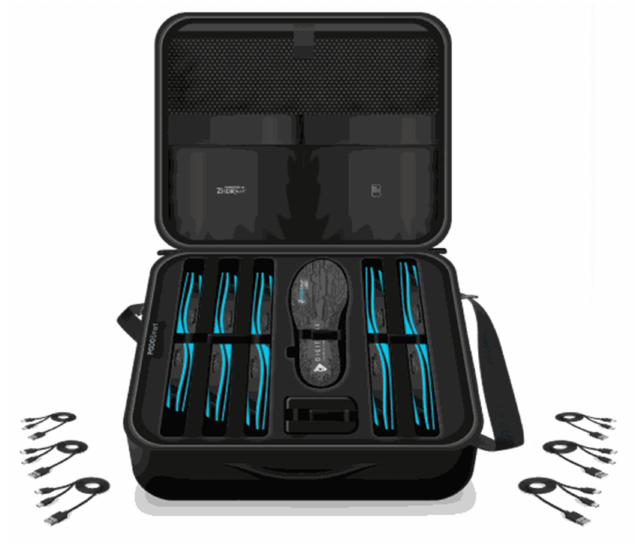
Figure 1. PODOSmart ® insoles gait analysis